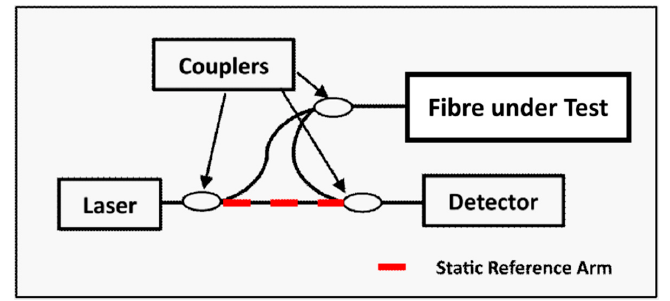
Figure 2. Schematic drawing of swept-wavelength interrogator (SWI)-based system with Mach-Zehnder interferometer.